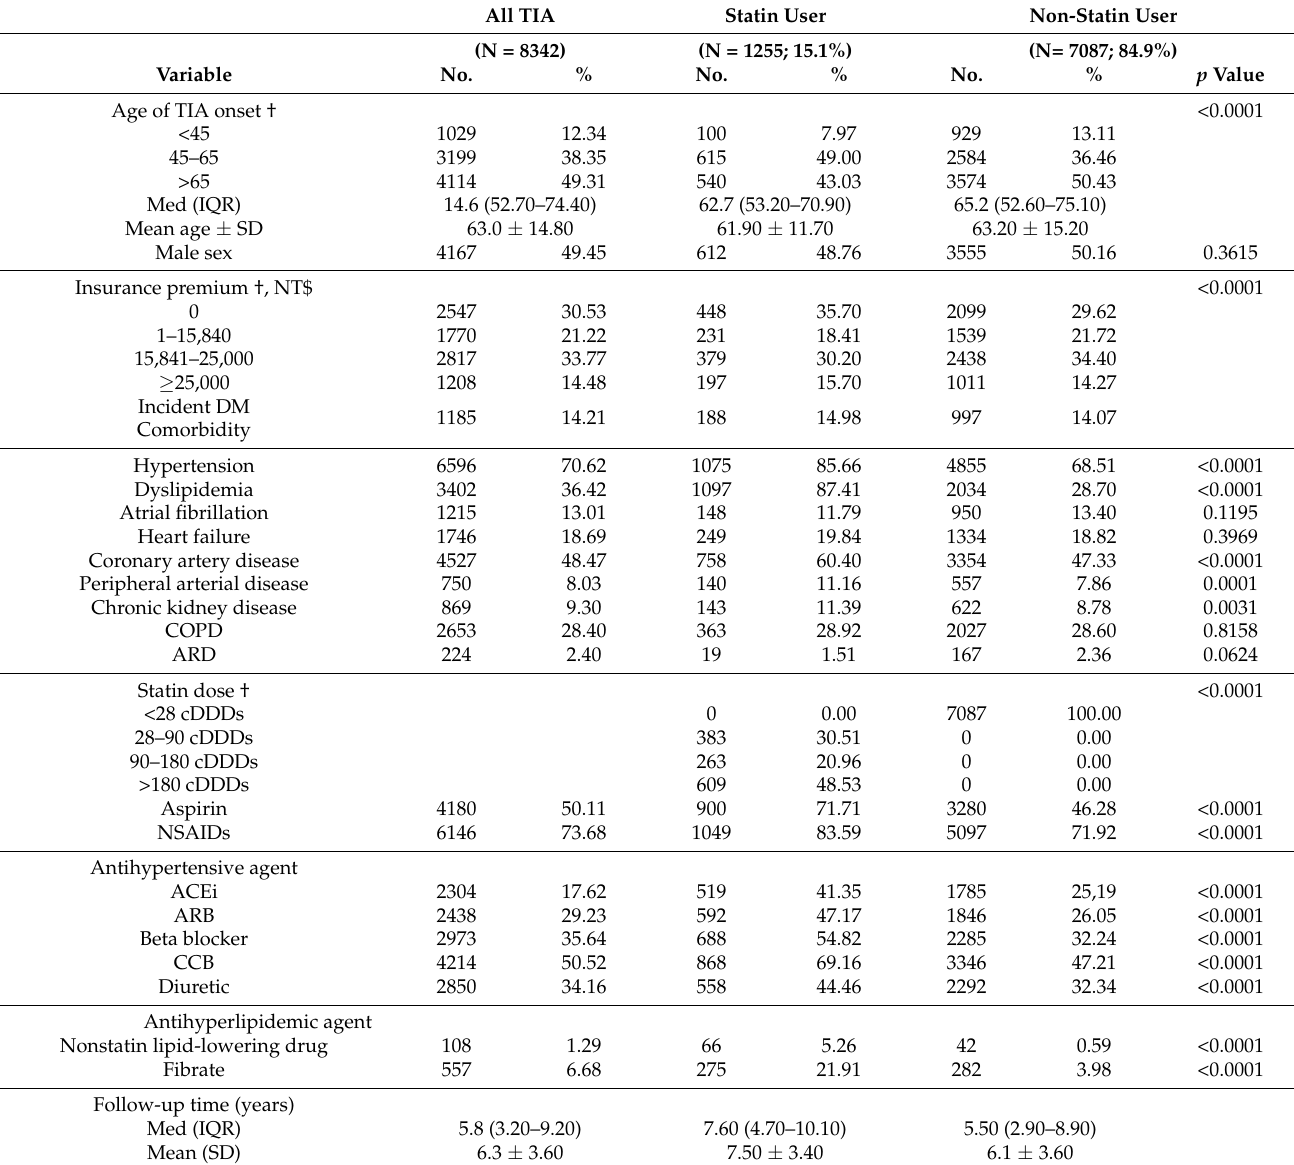
Table 1. Baseline demographics of patients with transient ischemic